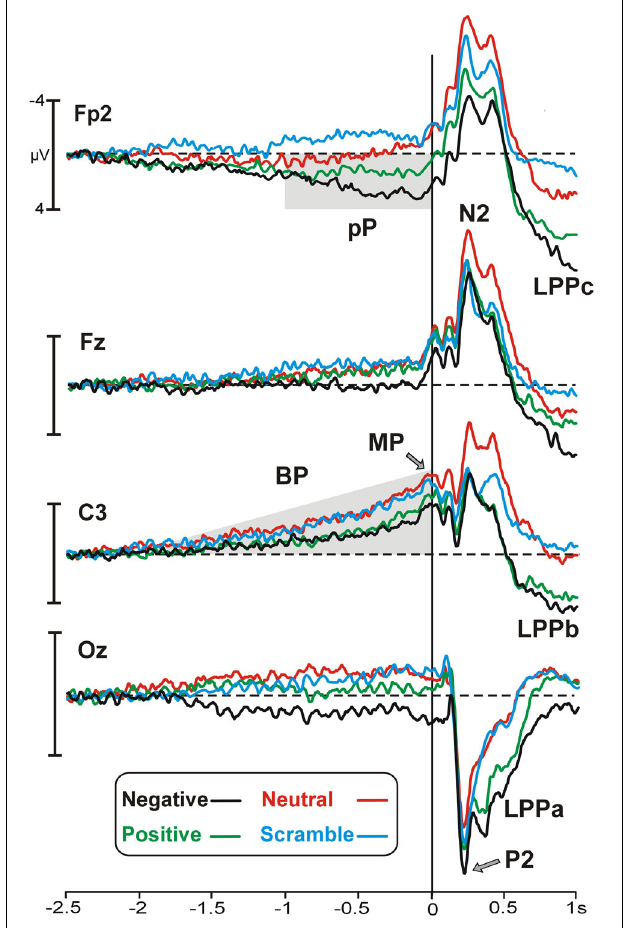
FIGURE 1 | Grand average waveforms of the emotional categories represented by different colors (specified in the legend) on the most relevant sites. Time zero corresponds to the key-press and the concomitant stimulus onset. Pp, prefrontal-positivity; BP, Bereitschaftspotential; MP, motor potential; LPP, late positive potential.